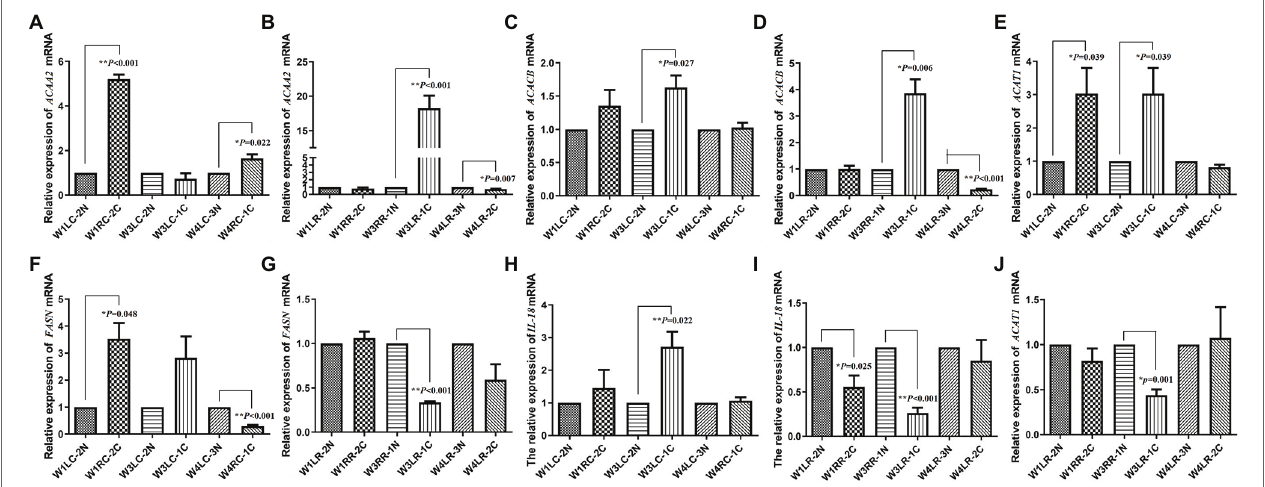
FIGURE 3 | Validation of transcript expression by quantitative PCR (qPCR). (A,B) The expression of ACAA2 mRNA in tree shrew choroid and retina, respectively; (C,D) The expression of ACACB mRNA in tree shrew choroid and retina, respectively; (E,J) The expression of ACAT1 mRNA in tree shrew choroid and retina, respectively; (F,G) The expression of FASN mRNA in tree shrew choroid and retina, respectively; (H,I) The expression of IL18 mRNA in tree shrew choroid and retina, respectively. Data are presented as mean ± SEM ( n = 3). GAPDH was used as a housekeeping internal control. Transcript expression was quantified relative to the expression level of GAPDH by 2 -ΔΔCT method. 0.001 ≤ * p < 0.05; ** p <